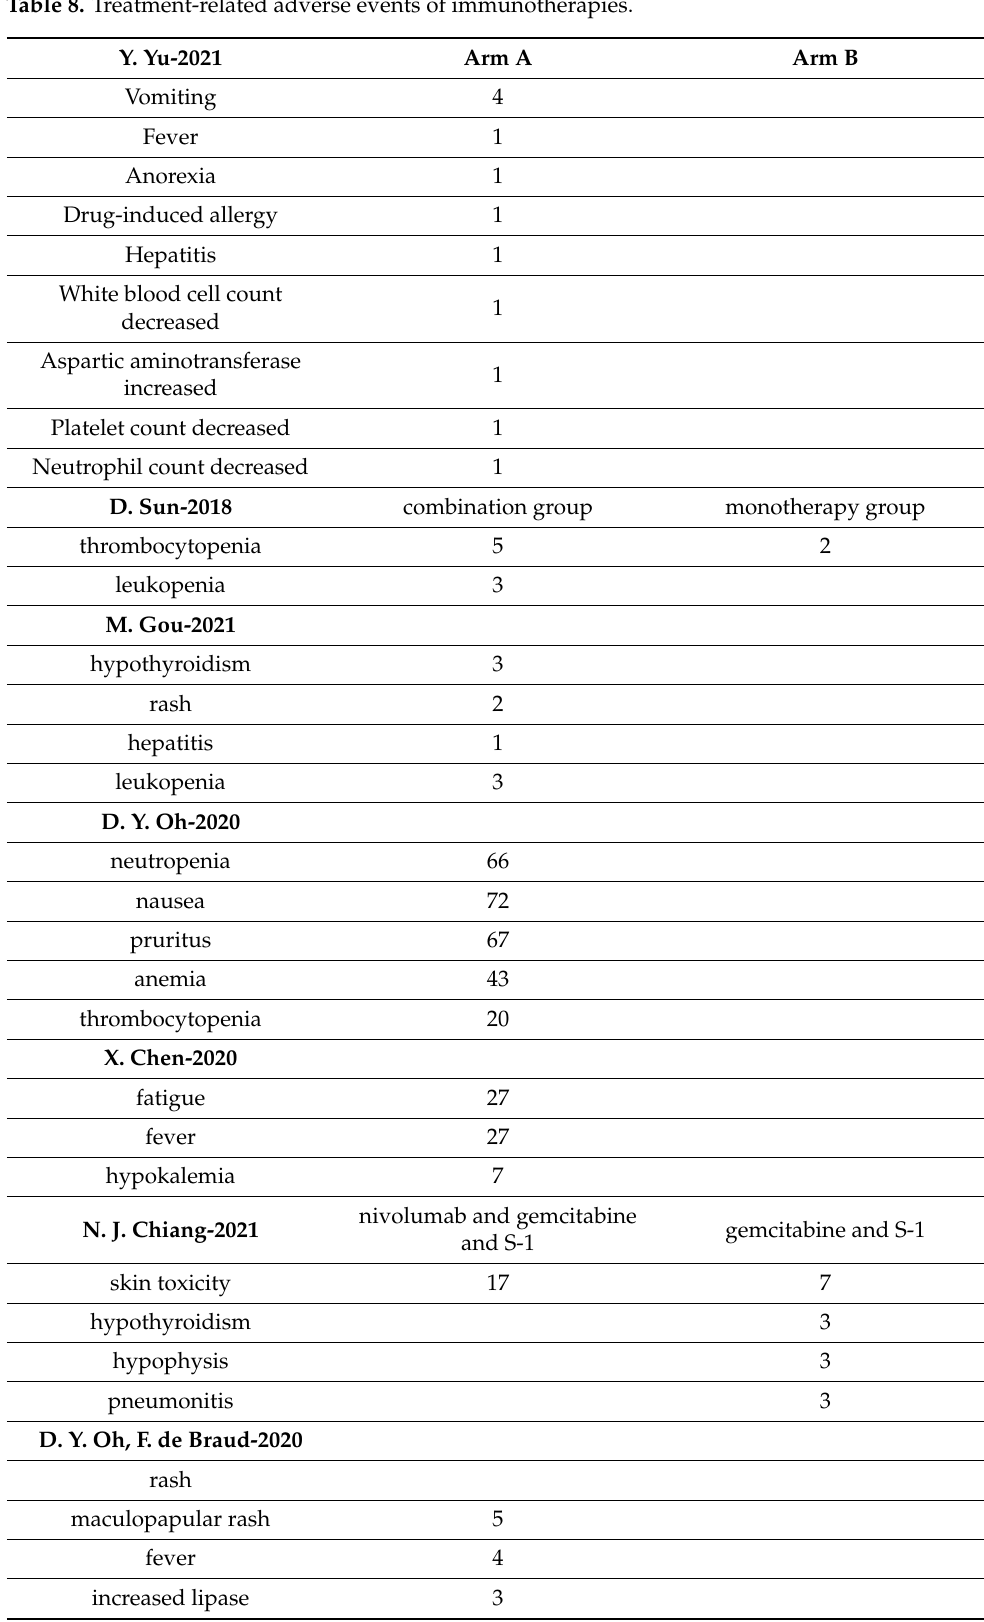
Table 8. Treatment-related adverse events of